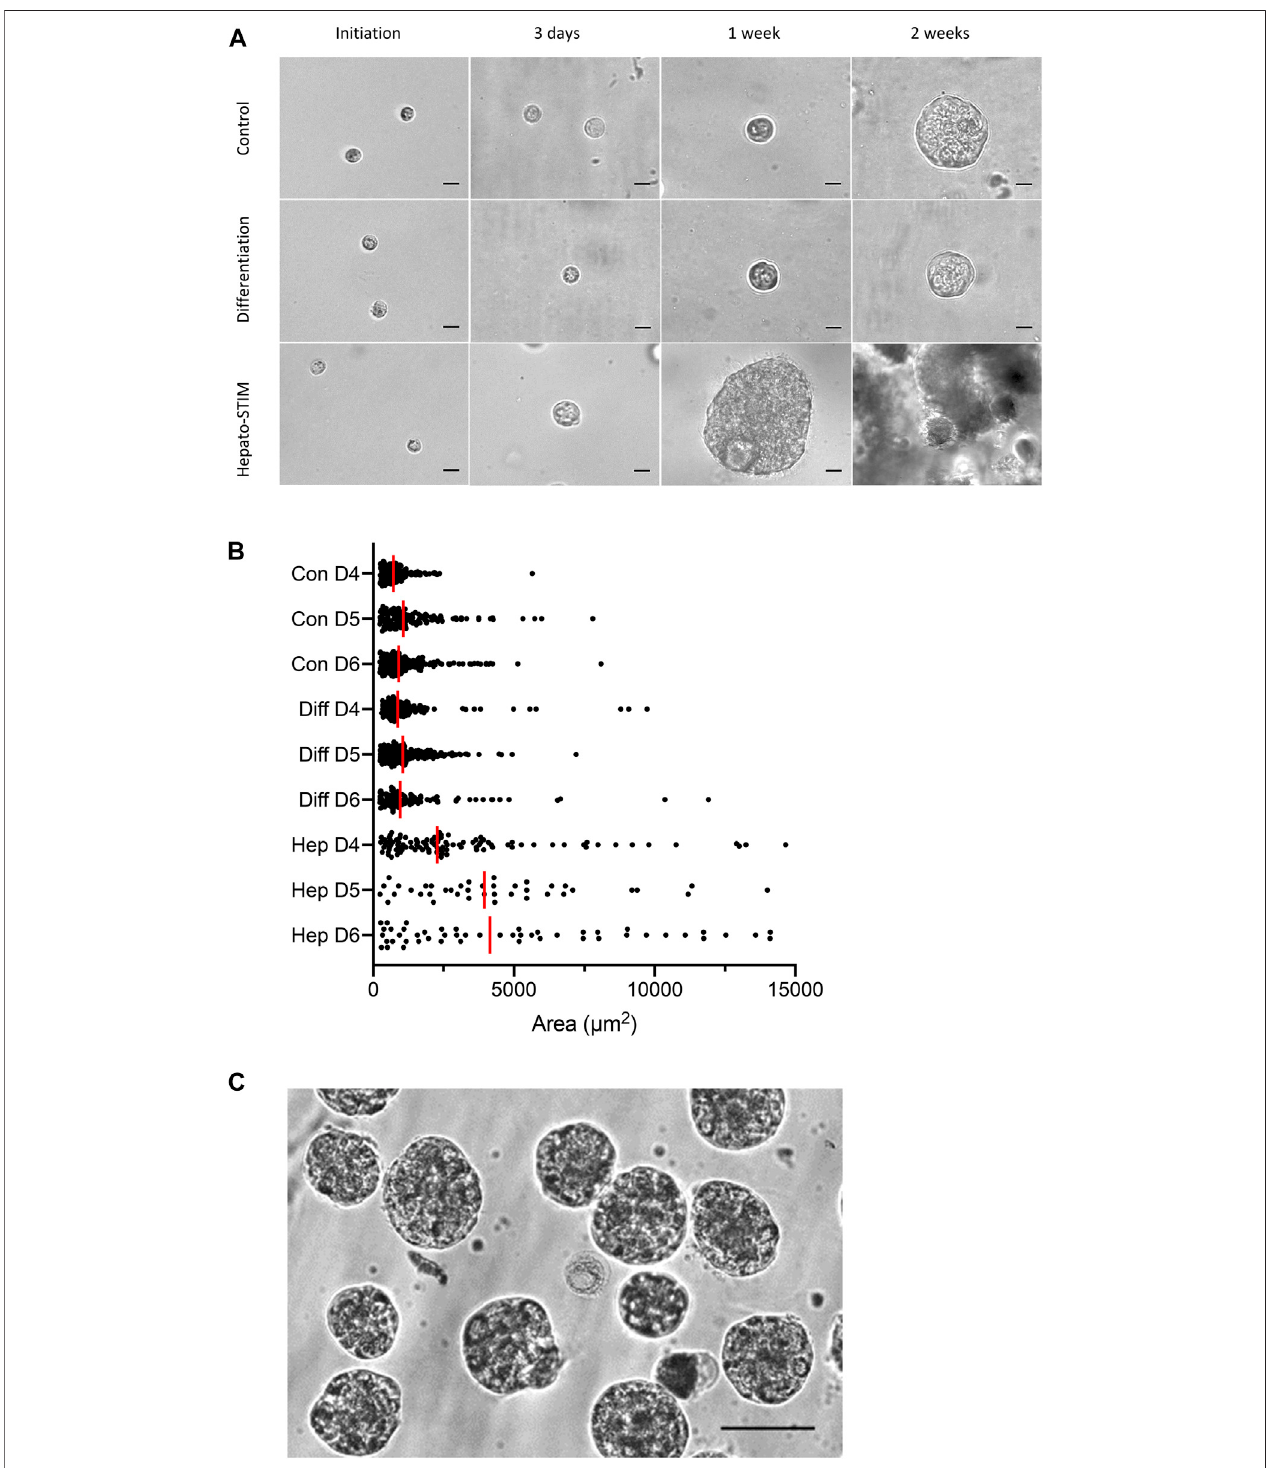
FIGURE 2 | Morphology of 3D HAT-7 cell cultures grown within a Matrigel matrix. (A) Time courses of growth and spheroid development when HAT-7 cells were seeded inMatrigelmatrix and incubated inthree differentculture media: control, differentiation and Hepato-STIM. Images were obtained on the dayofseedingand then after 3 days, 1 week and 2 weeks. (B) Size distribution of HAT-7 cells/spheroids in a representative experiment where growth in the three different culture media was compared on days 4, 5, and 6 (D4-D6). Each point represents the area of a single cell/spheroid and the vertical red bars indicate the median values. (C) HAT-7 spheroids isolated from the Matrigel matrix after 7 days of culture in Hepato-STIM and then plated on glass coverslips coated with poly- L -lysine in preparation for micro fl uorometry experiments to measure intracellular pH and calcium. Scale bars: 20 µm (A) , 75 µm (C) .